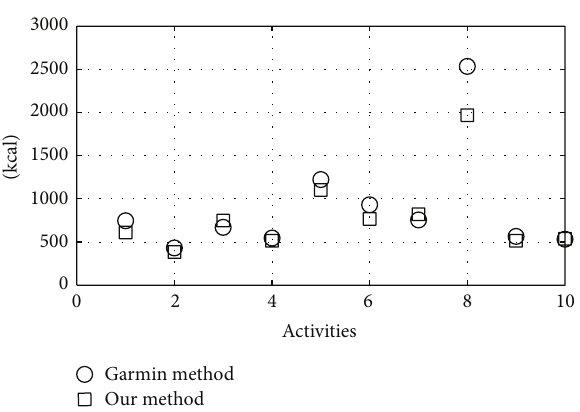
Figure 10: Comparison of calorie calculation data from the Garmin method and our algorithm.